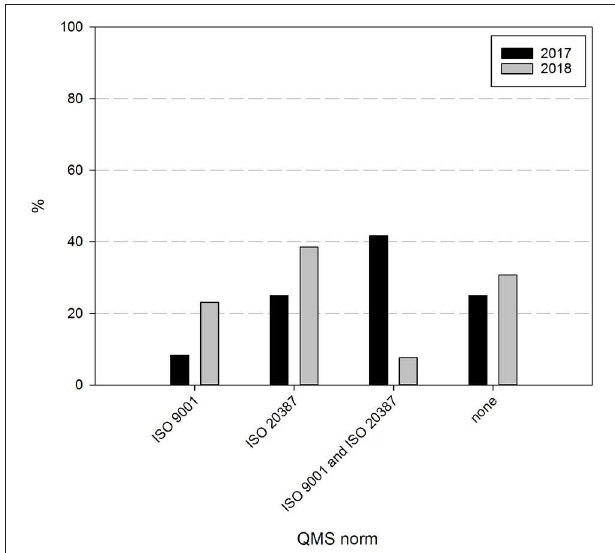
FIGURE 7 | Certification intentions biobanks in the BBMRI.be network. Participants were asked to indicate which if any certification/accreditation they intended to acquire within 2 years. Black bars show participants’ responses in 2017, gray bars show participants’ responses in 2018. All participants responded to all items